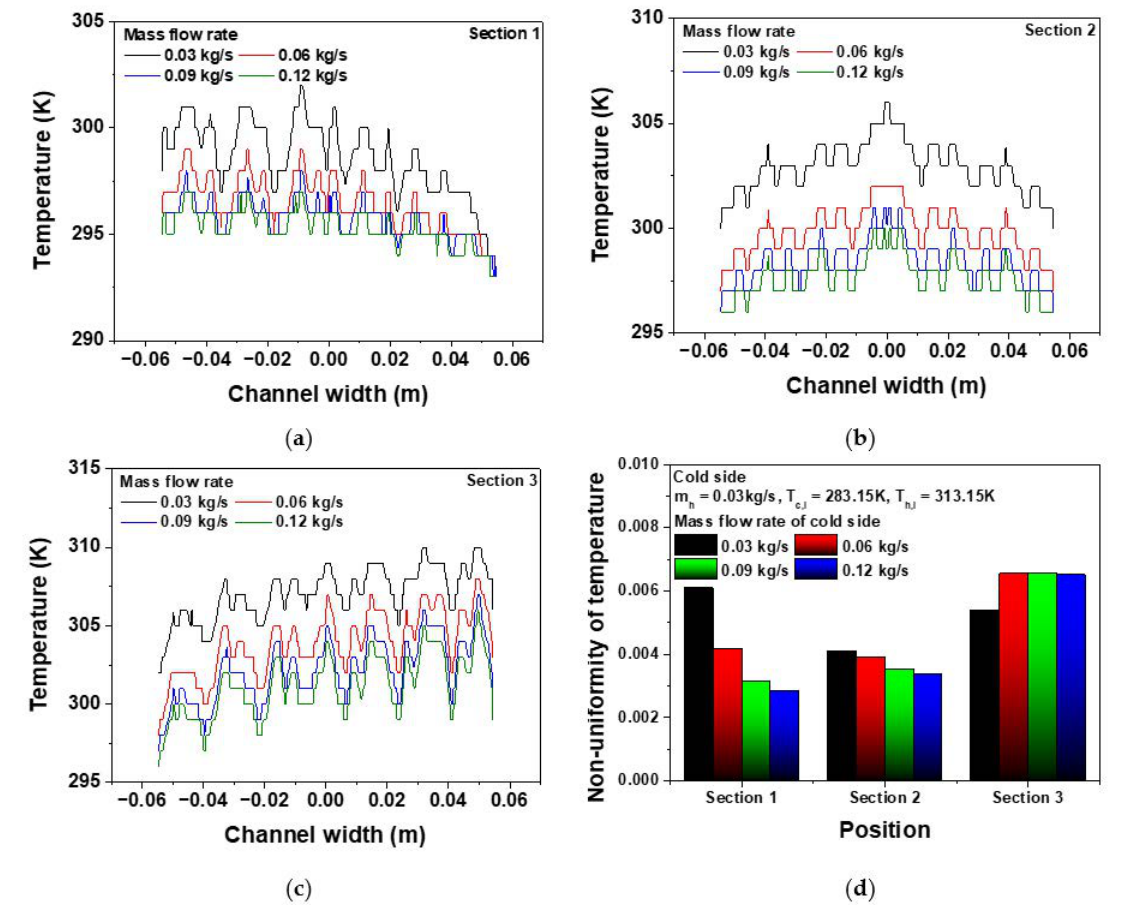
Figure 6. Cold side wall temperature: ( a ) Section 1, ( b ) Section 2, ( c ) Section 3, and ( d ) non-uniformity of